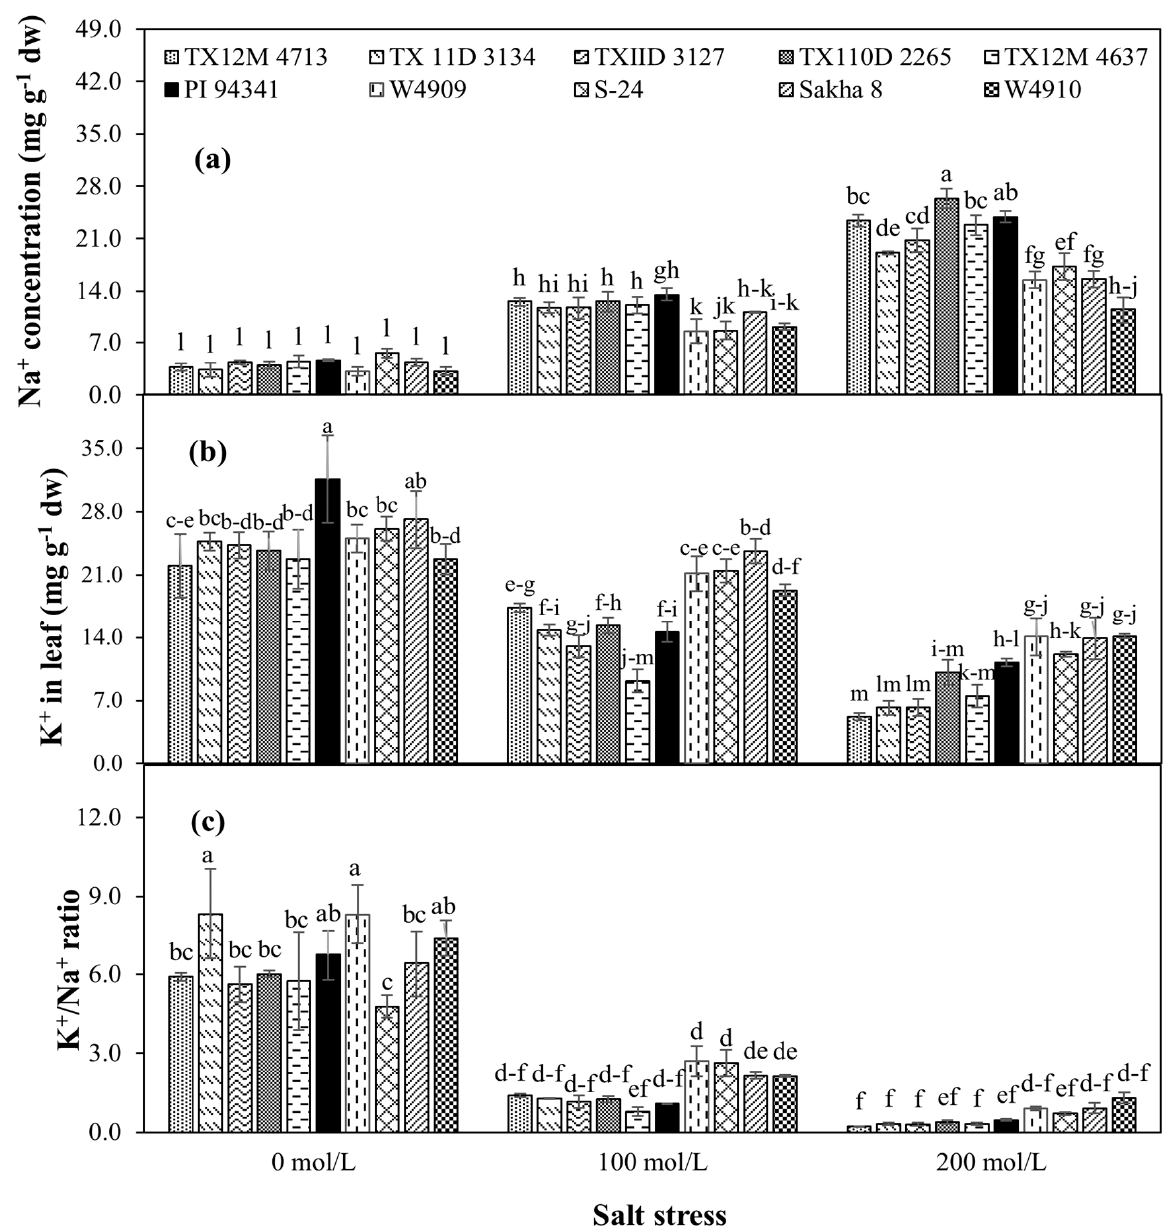
Figure 2. Influence of salt stress on ( a ) Na + concentration in leaves, ( b ) K + concentration in leaves, and ( c ) K + /Na + in leaves of wheat genotypes. Error bars indicate S.E. ( n = 3). Different letters above the bars represent significant differences at the p < 0.05.